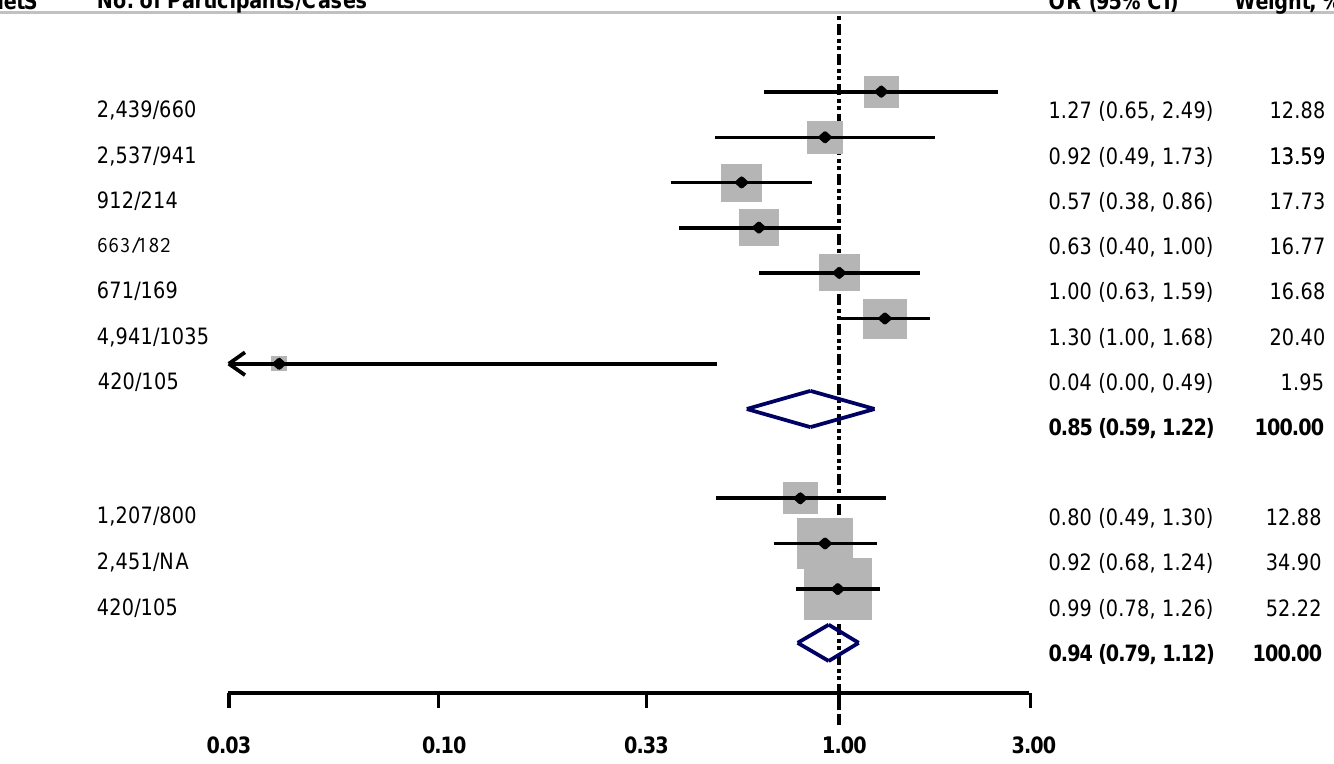
Figure 3. Multivariable adjusted ORs and 95% CIs (horizontal lines) for prevalence of metabolic syndrome from cross-sectional studies. The pooled estimates (diamond data markers) were obtained using a fixed-effects model. The dots indicate the adjusted ORs by comparing the highest to the lowest category of fish or LCω3PUFA intake. The size of the shaded square is proportional to the percent weight of each study. CI: confidence interval; NA, not available; OR: odds